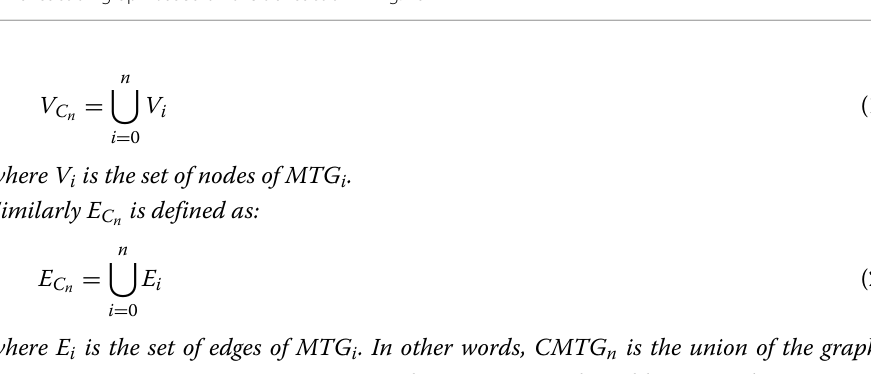
Fig. 1 Generation of a transaction graph. a An example of a transaction with 3 Inputs and 2 Outputs. b Transaction graph based on the transaction in Fig.